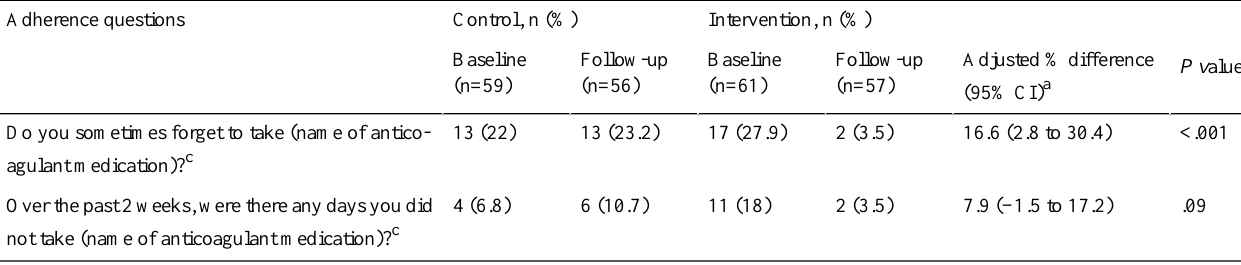
Table 3. Self-reported adherence to anticoagulation by treatment